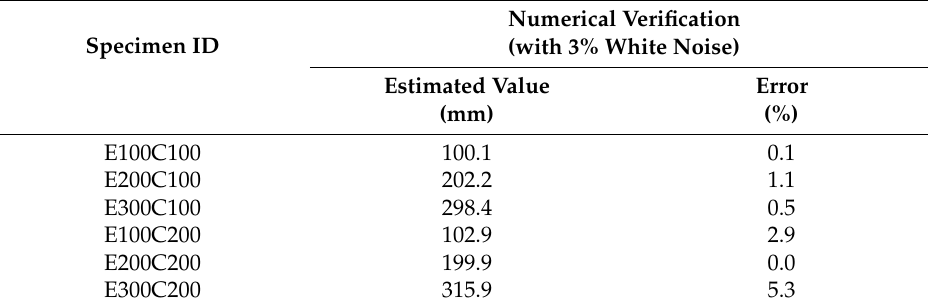
Table 2. Estimated embedment depth of the anchor bolt in numerical